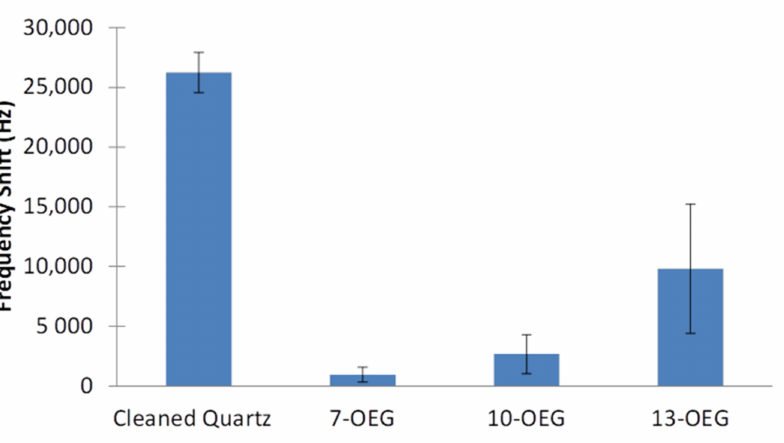
Figure 8. EMPAS non-specific adsorption frequency shifts measured with undiluted goat serum using a cleaned quartz crystal and 7–OEG, 10–OEG, 13–OEG